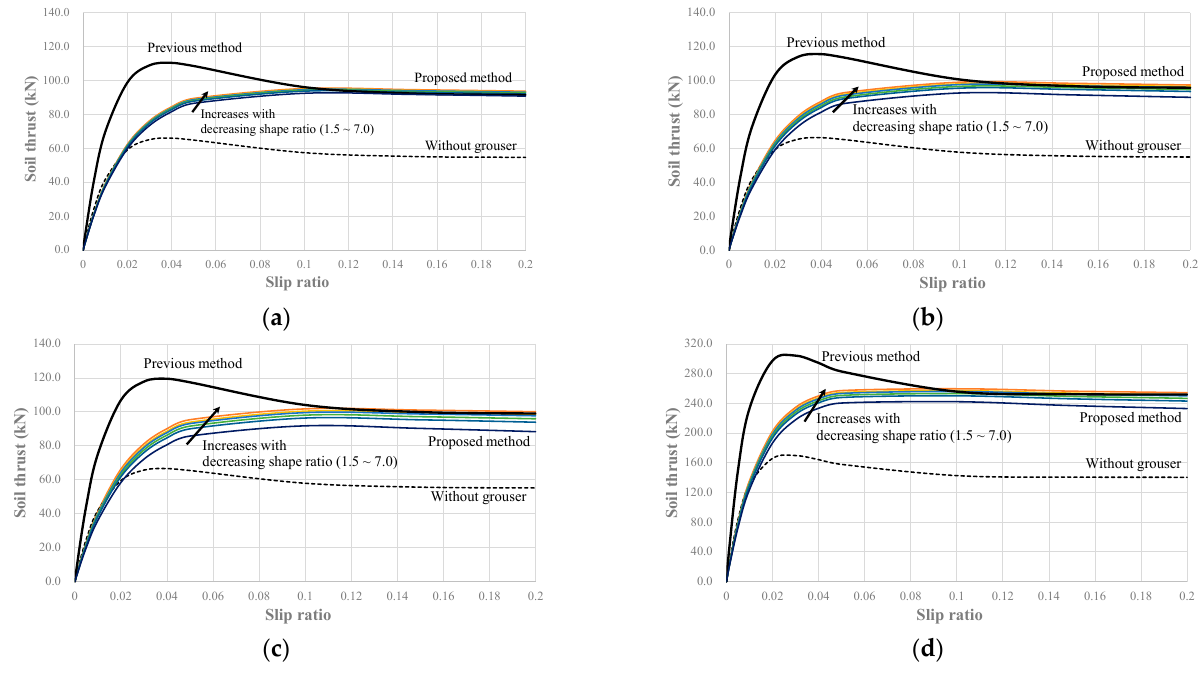
Figure 8. Soil thrust and slip displacement curves in soils exhibiting softening behavior ( c = 3.3 kPa, 𝜙 = 33.7° , K W = 9.3, K r = 0.835): EC145E with a grouser height of ( a ) 25 mm ( b ) 50 mm ( c ) 70 mm: ( d ) EC380E with 70 mm grouser height.